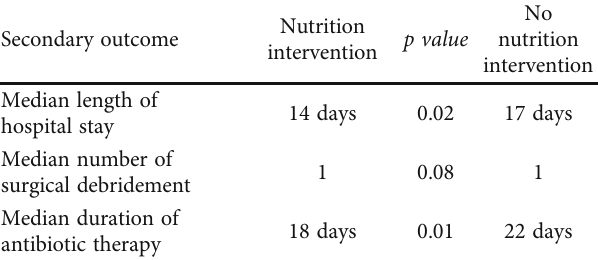
∗ Signi fi cant results are displayed in bold . “ - ” =not included in the model due to interaction (e ff ect modi fi cation) or clinical irrelevance regarding the study question; NRS=Nutritional Risk Screening Score 2002. Table 3: Secondary outcomes of treatment of diabetic foot infections strati fi ed by whether or not there was accompanying nutritionist